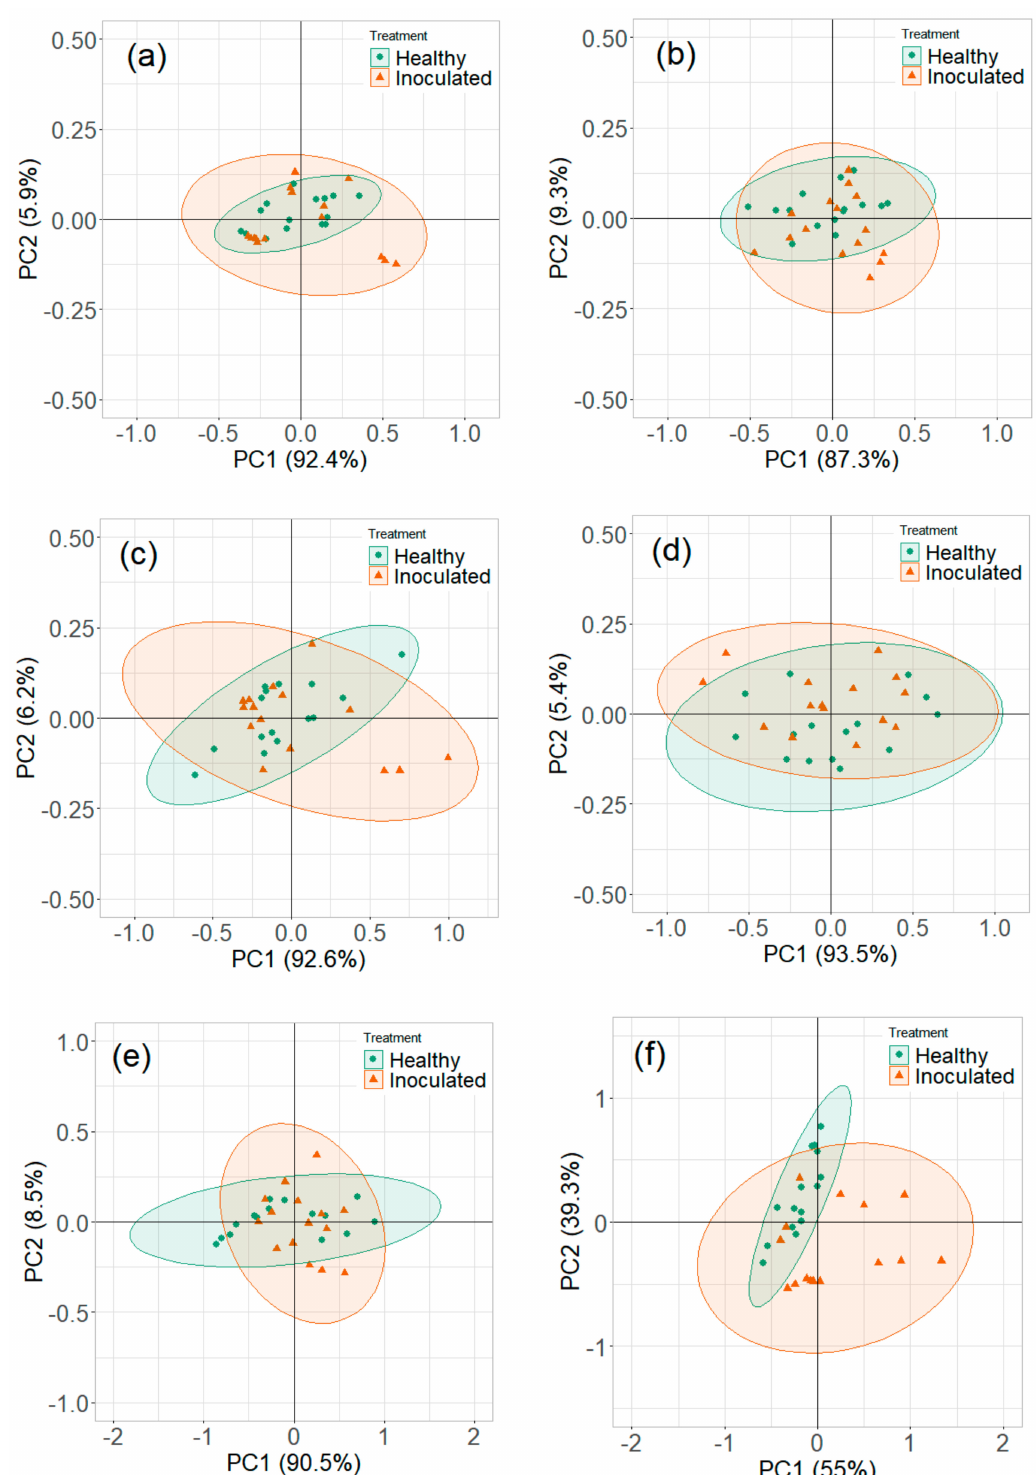
Figure 13. Principal component analysis plots for ion current of Russet Burbank tuber samples stored at reduced temperature (4 ◦ C, experiment-4) on ( a ) 0th, ( b ) 1st, ( c ) 5th, ( d ) 10th, ( e ) 15th, and ( f ) 31st days after